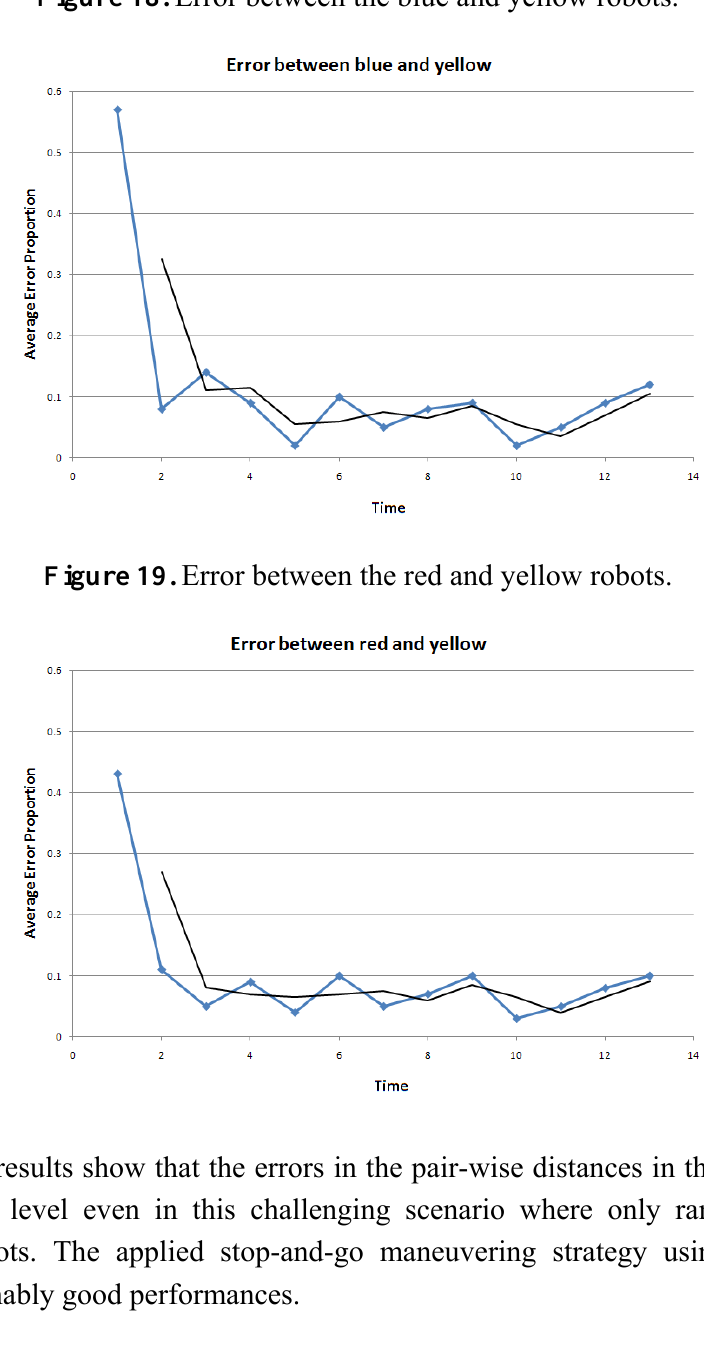
Figure 18. Error between the blue and yellow robots.